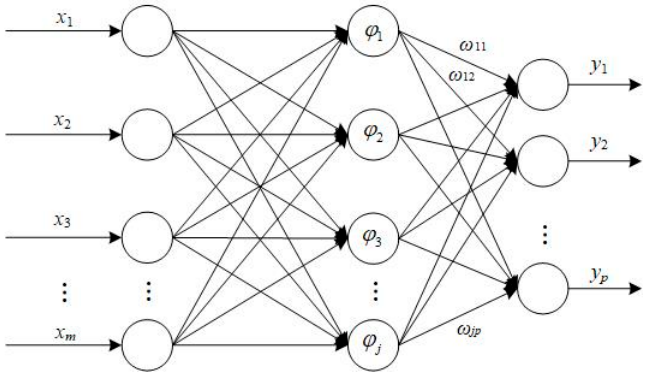
Figure 2. The structure of RBF neural network.